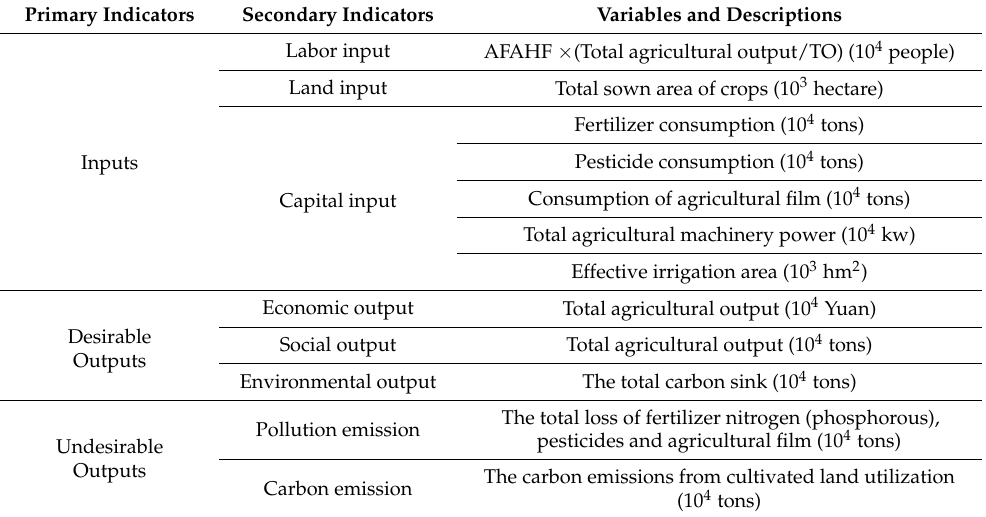
Table 1. The statistics for measuring